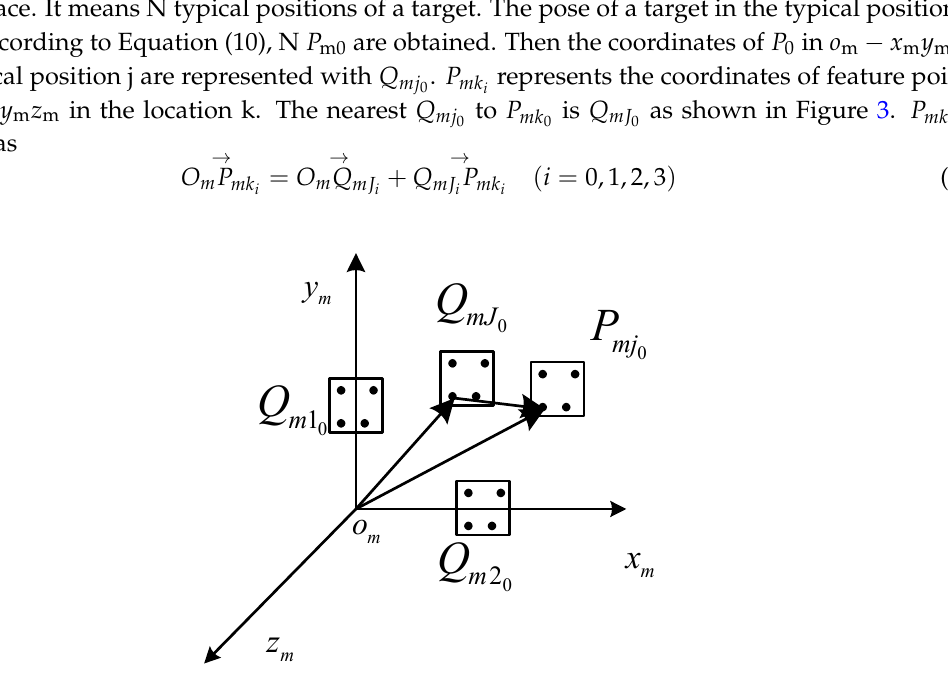
Figure 3. The solving of the object pose.